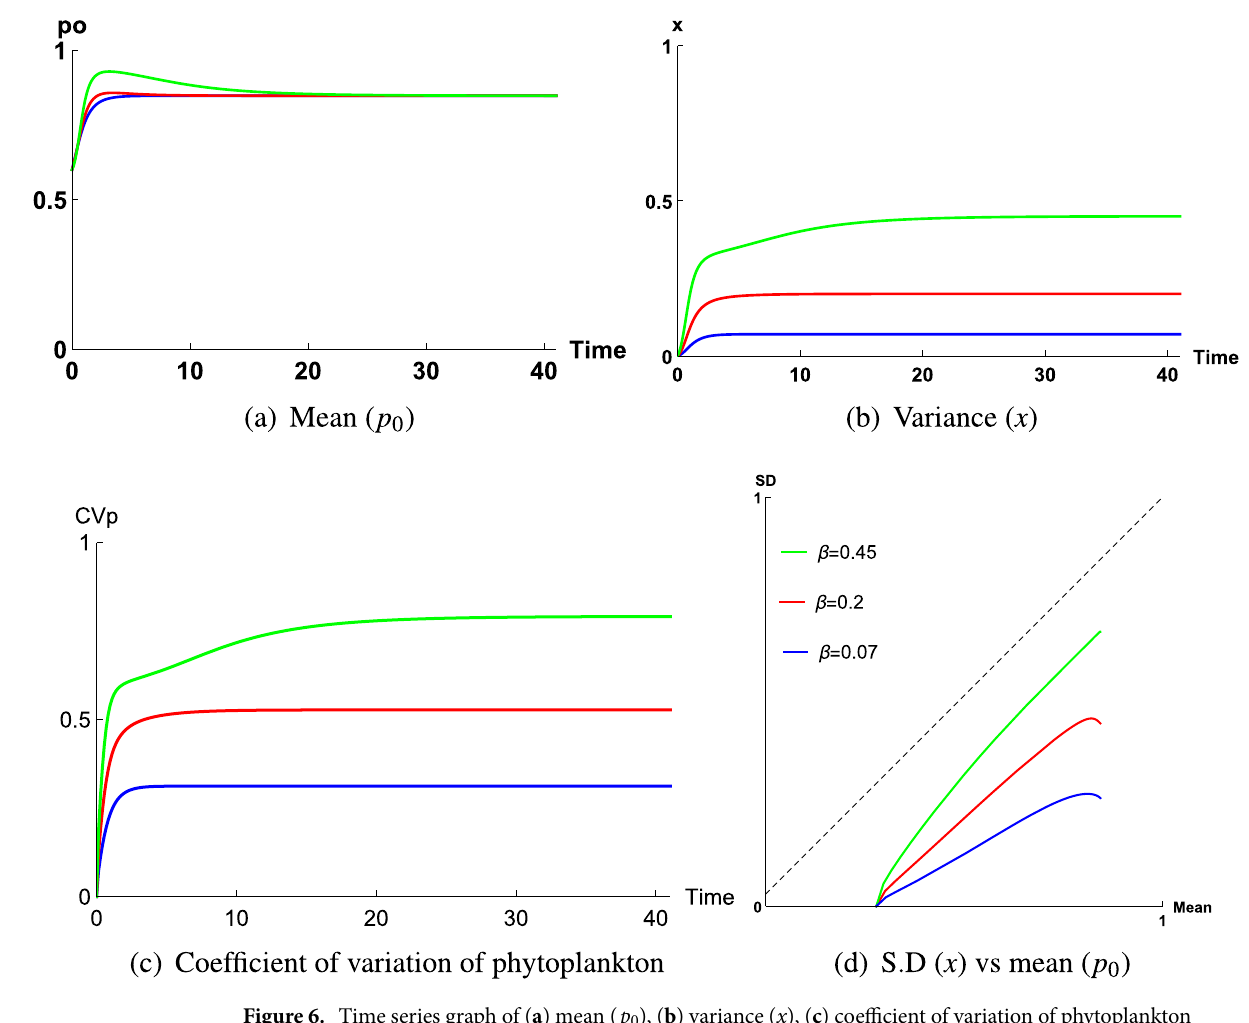
Figure 6. Time series graph of ( a ) mean ( p 0 ), ( b ) variance ( x ), ( c ) coefficient of variation of phytoplankton ( CV P ), and ( d ) corresponding parametric plot of coefficient of variation of phytoplankton ( CV P ) of the closure ( 0.035, 0.1 ) , considering total biomass is high, that is, A = 2 model, when β varies for a fixed ε , where ε ∈ µ gN l − 1 . The constant parameter values for this simulation are κ 1 µ gN l − 1 , A 2 µ gN l − 1 ) and 0.5 ( K = = = ε 0.085 for β 0.07, 0.2, 0.45 respectively. = =